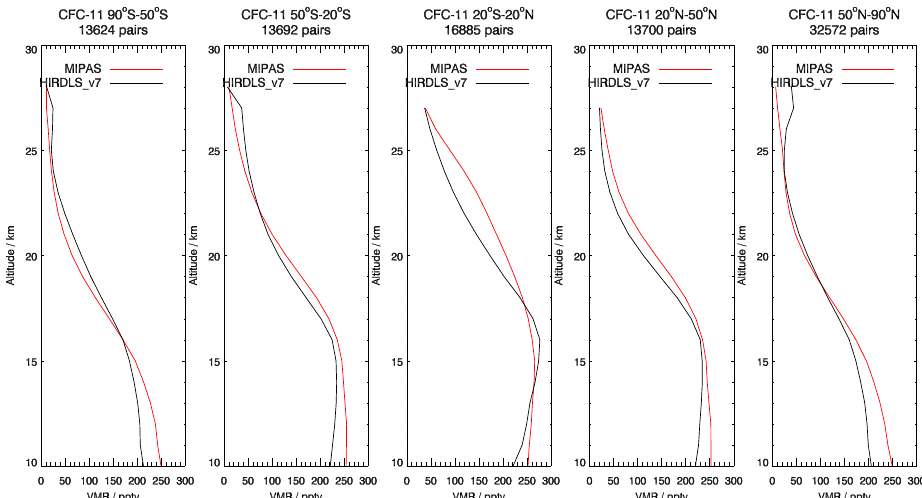
Figure A1. Comparison of mean profiles of MIPAS CFC-11 (red line) and HIRDLS (black line) for different latitude bins for the years of 2005–2008.